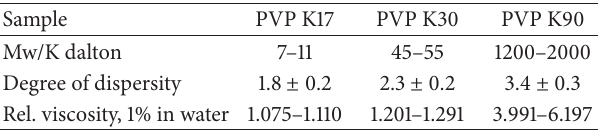
Table 2: Some of the basic properties of PVP as provided by the manufacturer, BASF,